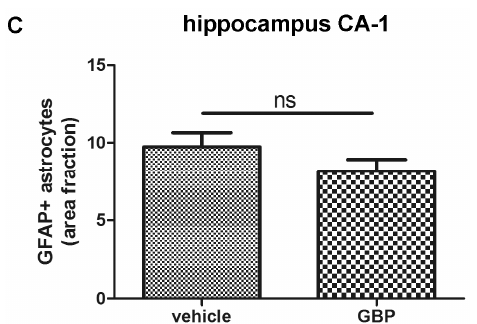
Figure 7. Gabapentin treatment reduced reactive astrogliosis in the piriform cortex of SE animals. ( A ) Representative images of GFAP+ immunostained astrocytes cells in the piriform cortex of gabapentin- (GBP) and vehicle-treated animals at 5DPSE, showing heterogeneous astroglial response to GBP treatment. Scale bar: 15 µ m. ( B ) Quantitative analysis of area fraction occupied by GFAP+ astrocytes in the piriform cortex. ( C ) Quantitative analysis of area fraction occupied by GFAP+ astrocytes in the stratum radiatum of hippocampal CA-1. Significance was evaluated by two tailed Student- t test; data are expressed as mean ± SEM; (*) represents p < 0.05 and n.s. is not statistically significant.